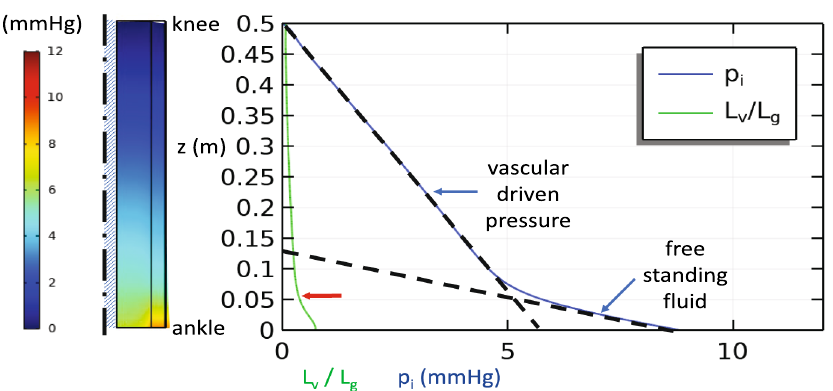
Figure 5. Multi-layer model with venous insufficiency. Parameter values plotted in subcutaneous layer. Note how the transition to free-standing fluid occurs lower on the leg (red arrow) than in Fig.